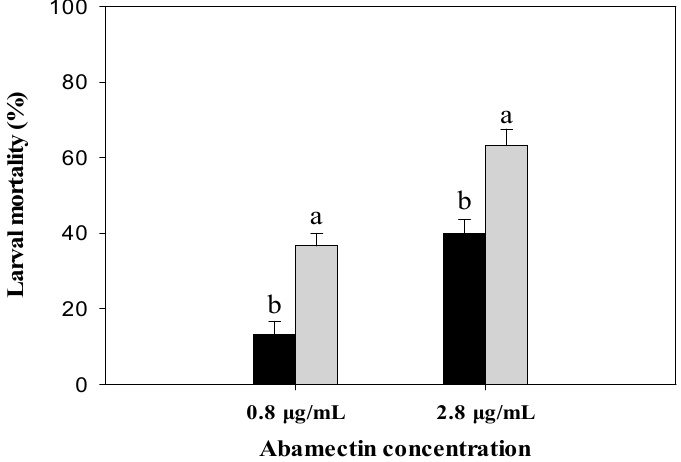
Figure 6. Mortality of strain ABM-R after the third instars were injected with dsRNA targeting CYP340W1 (grey bars) or with dsRNA targeting EGFP (black bars) and then treated with one of two concentrations of abamectin. The larvae were treated with abamectin 6 h after they had been injected with the dsRNA, and mortality was assessed 48 h later. Values are means and standard errors. Means with different letters are significantly different ( p < 0.05; Tukey’s test; n = 3).